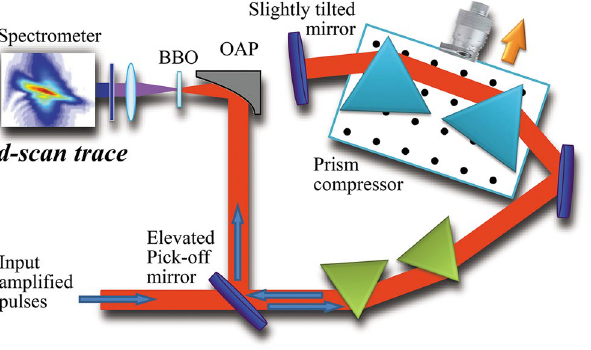
Figure 4. Experimental setup for the prism-compressor self-calibrating d-scan. The dispersion is scanned from negative to positive by controlling the prism insertion with a translation stage in the second prism pair of the double-pass compressor. The output pulse is focused with an off-axis parabola (OAP) onto a BBO crystal, after which it is collimated with a fused silica lens and the fundamental beam is suppressed with a blue filter. The SHG signal is measured with a spectrometer for 51 consecutive prism insertions, hence producing the d-scan